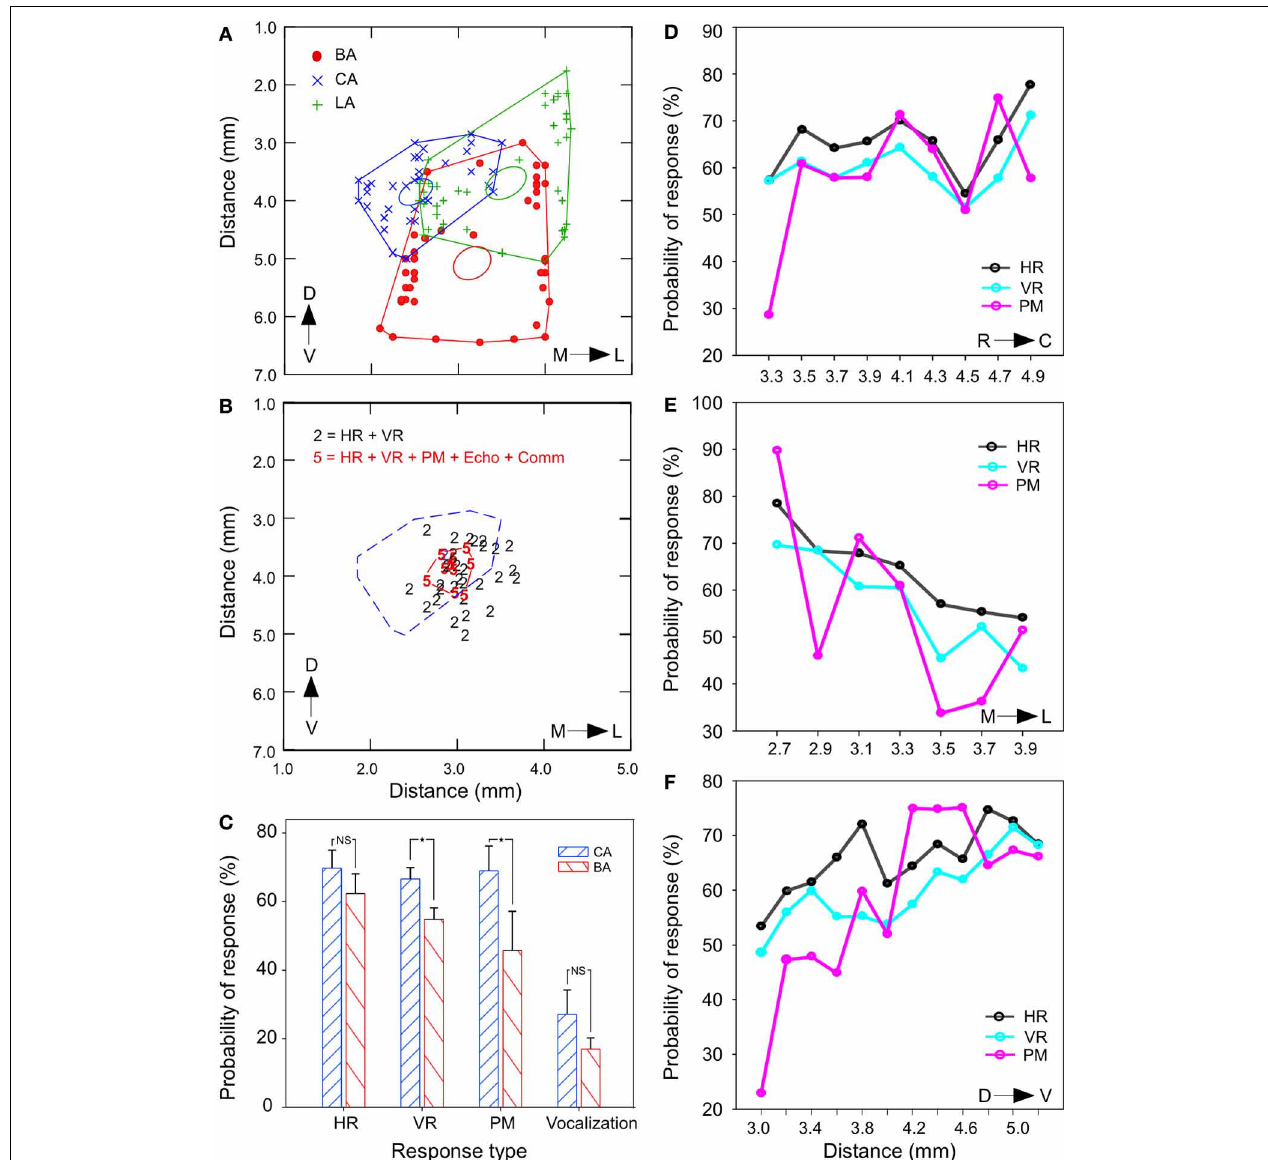
FIGURE 7 | Spatial distribution and overlap of multimodal response sites in the BA and CA. (A) Scatter plots with lines connecting the outermost shell of BA, CA, and the LA on a rostrocaudally flattened map of the amygdala in one animal. Ellipsoids indicate the centroid (0.95 confidence level) of each scatterplot. Data points marked by symbols represent measurements at multiple rostrocaudal levels. The LA is relatively large at the anterior end and the BA covers a large portion of the amygdala at the posterior end. Mediolateral measurements are from midline and dorsoventral measurements are from the surface of the brain. (B) Location of stimulation sites that yielded all 5 modalities (labeled as “5”) of response output vs. those that yielded only 2 types of autonomic (HR and VR) output (labeled as